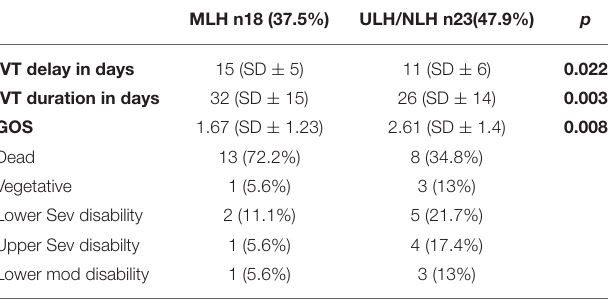
TABLE 2 | Comparison between Multiloculated vs. uni/non-loculated hydrocephalus (MLH/ULH/NLH) in terms of delay in intraventricular treatment in days, Glasgow outcome score (GOS).